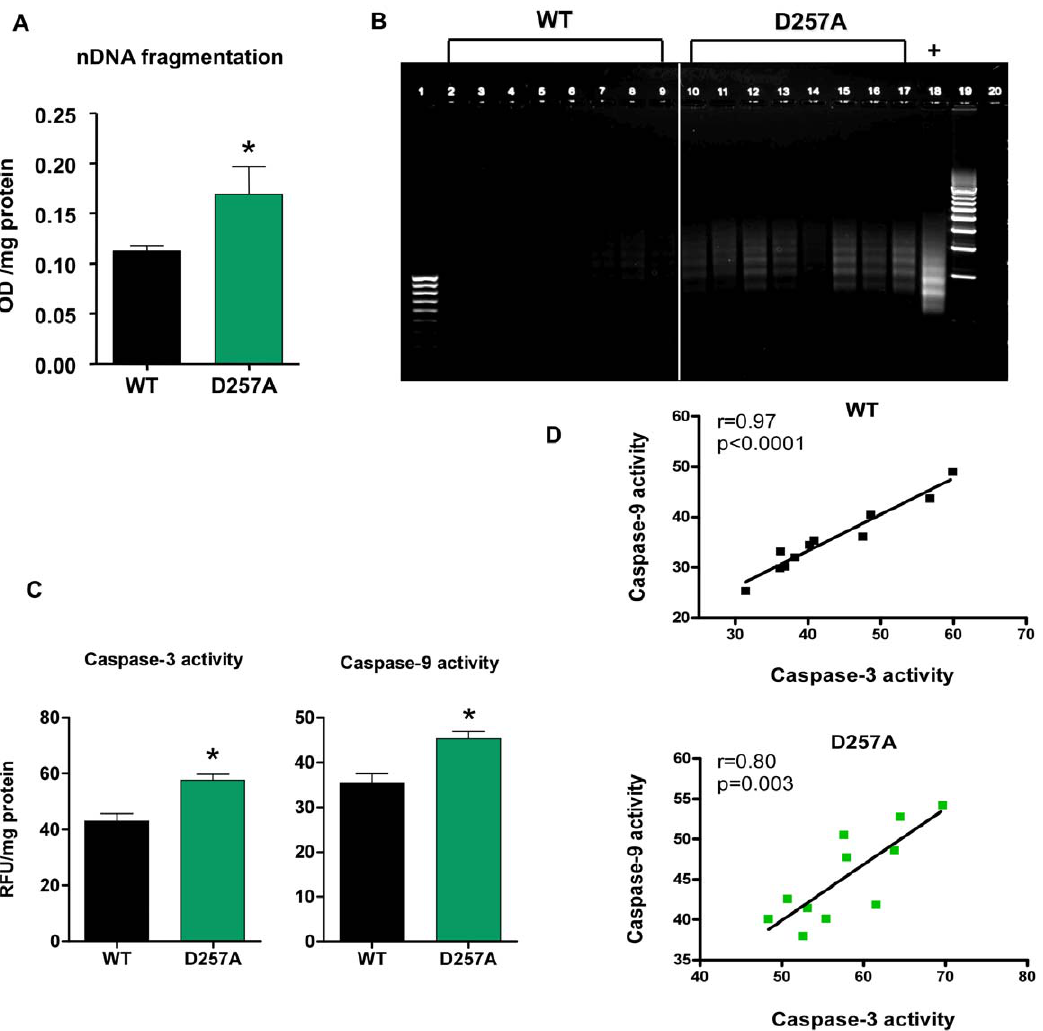
Figure 10. Apoptosis is evident in D257A muscle by increased cytosolic DNA fragments, DNA laddering, and caspase activation. (A) Cytosolic fractions from 11-mo old WT and D257A skeletal muscle (n=11 per group) were prepared. Nuclear DNA fragmentation was quantified as the amount of mono- and oligo-nucleosomes present in the cytosol, using a sandwich ELISA. Mean values 6 SEM are shown. *p , 0.05. OD: optical density. (B) DNA from 13-mo old WT and D257A (n=8 per group) mice was extracted and subjected to a DNA laddering-specific ligation PCR. PCR products were electrophoresed through 1% agarose gels and visualized under UV light for apoptosis-specific DNA ladders of , 180–200 bp multiples. Lane 1: 100 bp molecular marker. Lanes 2–9: WT PCR products. Lanes 10–17: D257A PCR products. Lane 18: Positive control. Lane 19: 500 bp molecular marker. (C) Cytosolic fractions from 11-mo old WT and D257A skeletal muscle (n=11 per group) were prepared. Caspase -3 and -9 activities were measured using a fluorometric protease assay kit which is based on detection of cleavage of the substrates DEVD-AFC or LEHD-AFC by caspase- 3 and -9 respectively. Mean values 6 SEM are shown. *p , 0.002. RFU: raw fluorescent units. (D) Caspase-3 activity was correlated with caspase-9 activity in WT and D257A mice (n=11 per group). Pearson correlation r values are shown in the top right corner. Correlations were significant for both genotypes; WT: r=0.97, p , 0.0001 and D257A: r=0.8, p , 0.003.